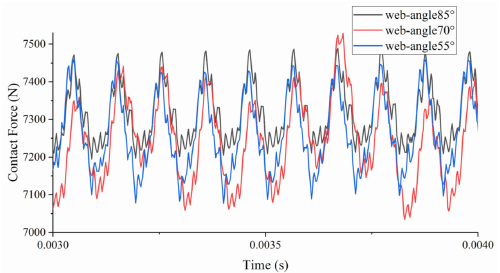
Figure 8. Contact forces of models with different web support angles.